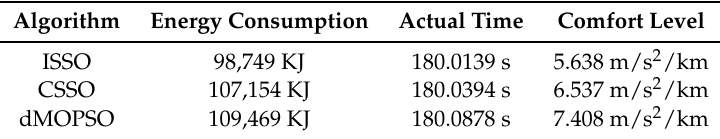
Figure 7. The Matlab/simulink optimization curves of different algorithms for rail transit line No.12 in Dalian scenario. ( a ) Target velocity trajectory profiles. ( b ) Operating condition distance curves. ( c ) Iterative convergence curves of each optimization objectives. ( d ) Iterative convergence curves of unified goals. Table 6. The Matlab/simulink optimization results of different algorithms for rail transit line No.12 in Dalian scenario.